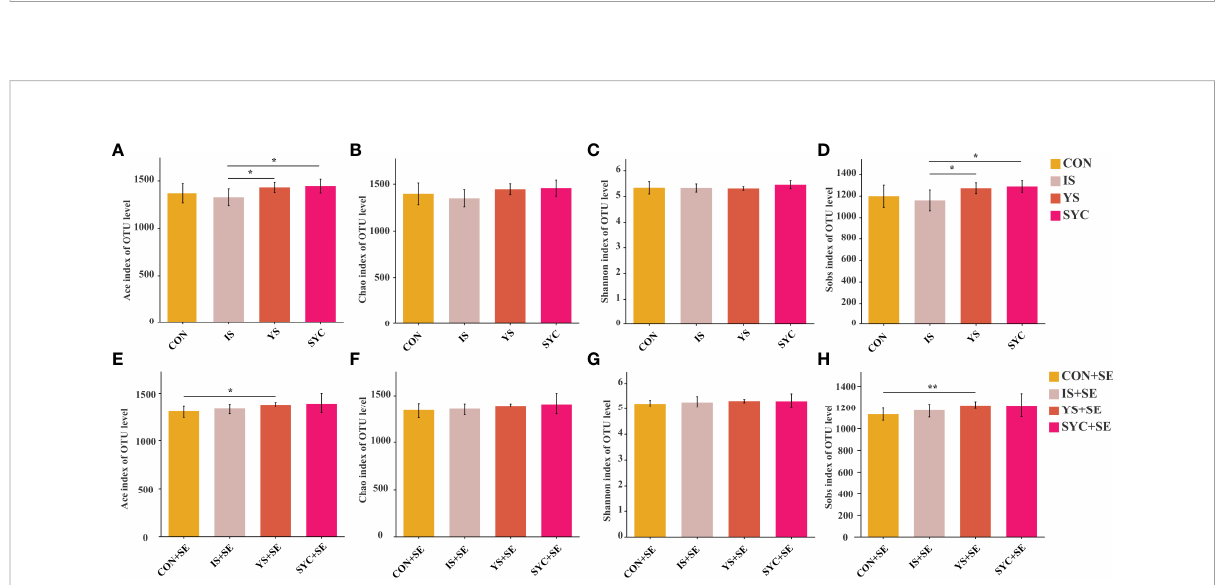
FIGURE 8 Effects of dietary supplementation with different Se sources on the alpha diversity of the cecal microbiota in layers challenged with S. Enteritidis . CON, basal diet; IS, sodium selenite; YS, yeast selenium; SYC, selenium-enriched yeast culture; CON+SE, IS+SE, YS+SE, and SYC+SE mean CON, IS, YS, and SYC challenged with S. Enteritidis , respectively. (A, E) Ace index of OUT level, (B, F) Chao index of OUT level, (C, G) Shannon index of OUT level, and (D, H) Sobs index of OUT level. The data were presented as means ± SEM. Signi fi cance was compared with every other group; * P < 0.05, ** P <